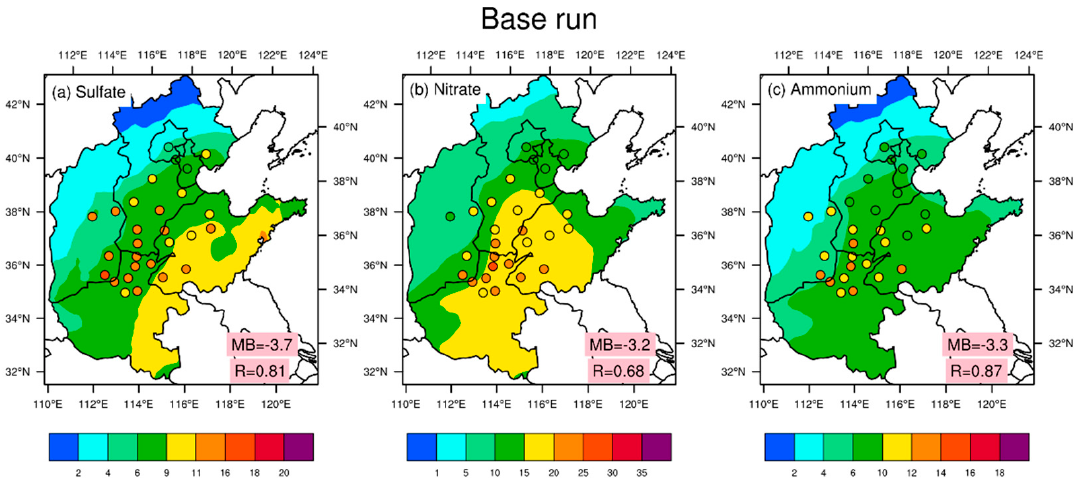
Figure 2. Simulated (shaded areas) and observed (solid circles) mean surface sulfate ( a ), nitrate ( b ) and ammonium ( c ) concentrations ( µ g m − 3 ) at the 28 sites across North China Plain from 1 October 2017 to 31 March 2018. The simulation results are the mean values over six months.